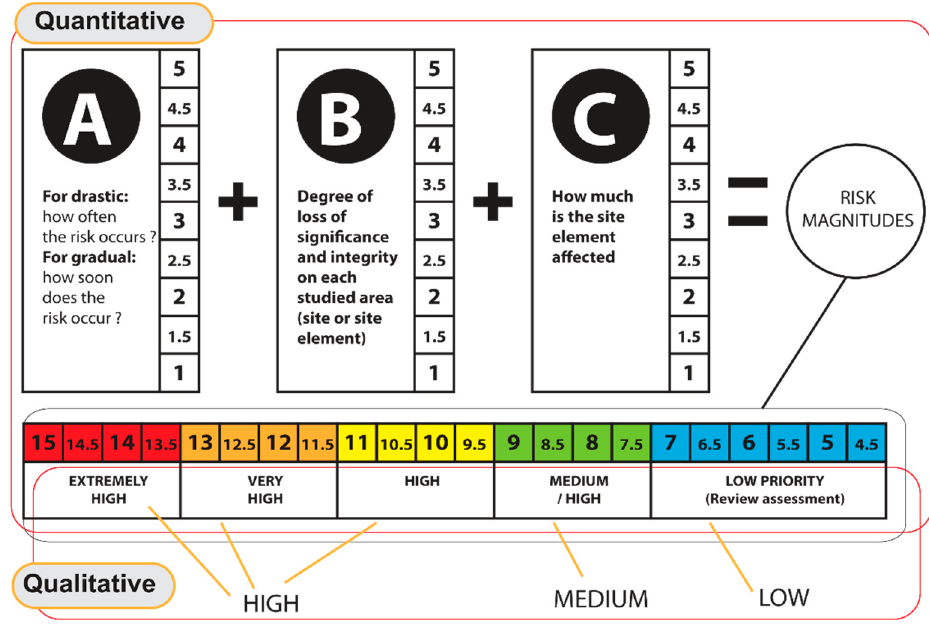
Figure 8. The evaluation method proposed by Paolini et al. in 2012 [10].